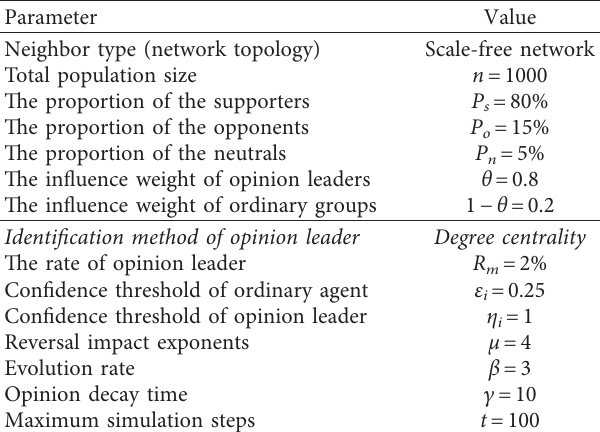
Table 2: Default simulation